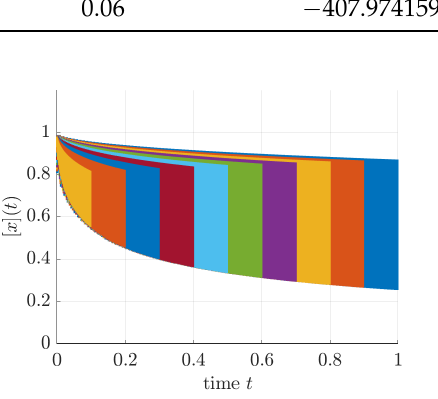
Figure 3. Simulation of the system model (39) using Theorem 3.